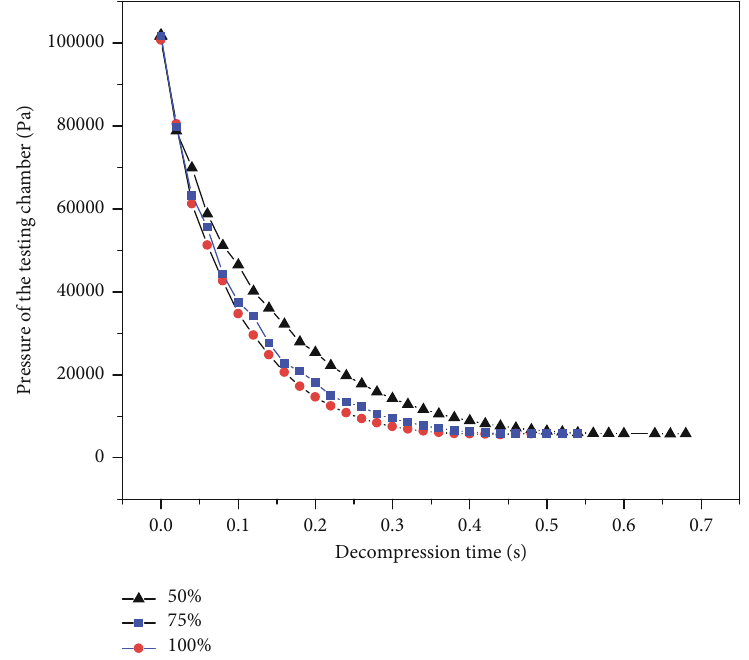
Figure 5: The pressure variation of testing chamber under di ff erent